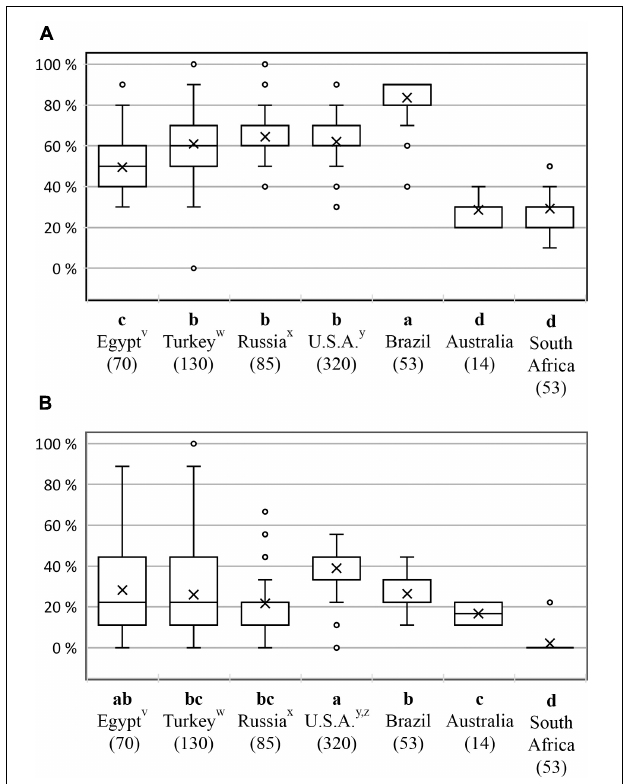
FIGURE 2 | Complexity of virulence in recently phenotyped Blumeria graminis f. sp. tritici populations from several countries compared to previously published virulence data for the United States and Egypt, for (A) 10 lower-numbered, older Pm genes ( Pm1a – Pm17 ) and (B) nine newer Pm genes recently introgressed into hexaploid wheat from wild relatives ( Pm25 – Pm53 ). Virulence complexity was calculated as mean percentage of Pm genes to which isolates were virulent. Within a panel, countries topped by the same letter did not have significantly different virulence complexities ( p < 0.05). Within each box, medians of virulence complexity are indicated by lines and means by crosses. v Abdelrhim et al. (2018). w Turkey/Black Sea region: isolates from Russian locations Krasnodar and Rostov were grouped with those from Turkey (refer to Table 1). x Western Siberia region: isolates from Karabalyk, Kazakhstan were grouped with those from Russia (refer to Table 1 ). y Cowger et al. (2018). z Genes Pm25 – NCA6 were effective in the field against a natural United States Bgt population (Cowger et al., 2018); see